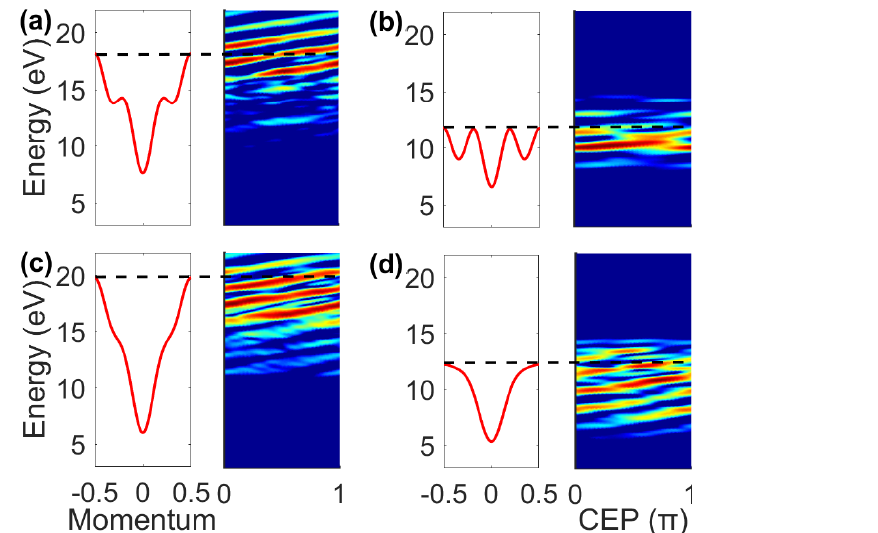
Figure 2. Panels ( a – d ) show four CEP-dependent HHG spectra and the corresponding band gaps, randomly generated. The black dashed lines show the HHG cutoff, linked to the high-energy region of the band gap. Every HHG spectrum shares the same colorbar with a normalized intensity. All the panels confirm the strong influence of the band gap shape on the HHG, especially for the high-energy